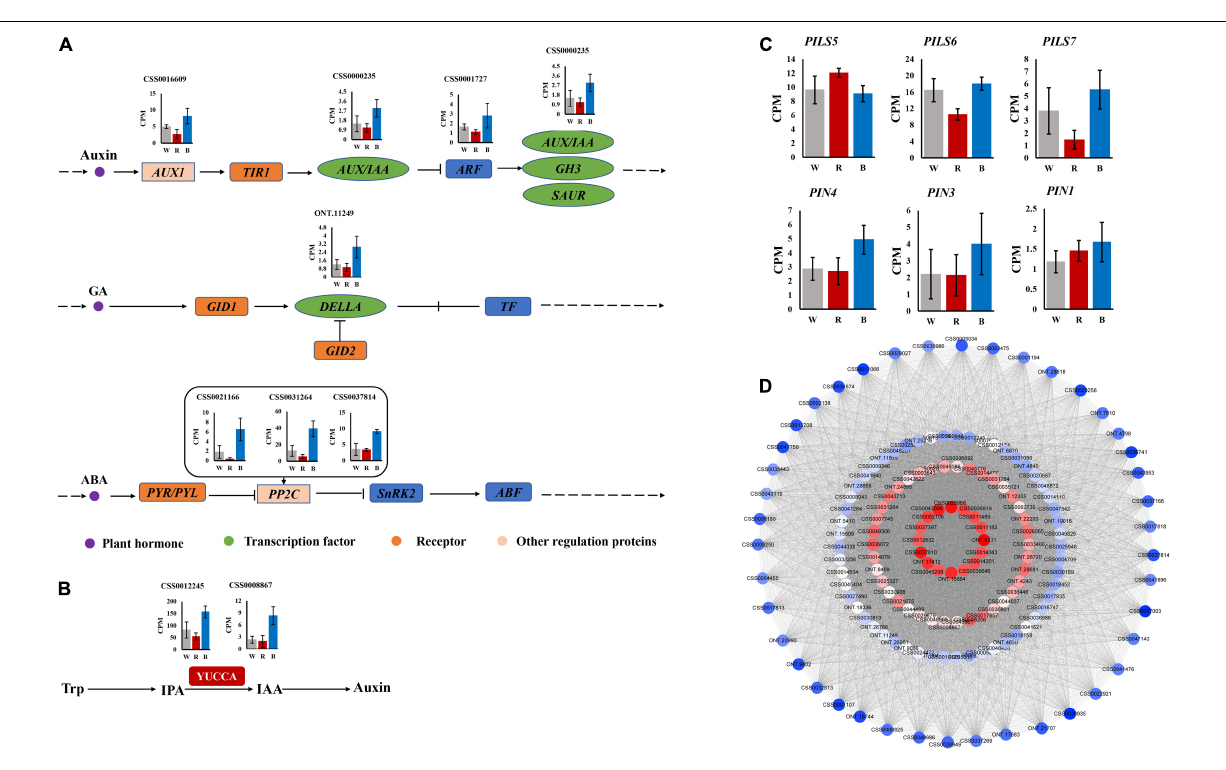
FIGURE 6 | (A) Auxin, GA and ABA signaling pathways. (B) Auxin synthesis pathway. (C) Expression of auxin transport-related genes. (D) Correlation network graph of genes in “MEblue”